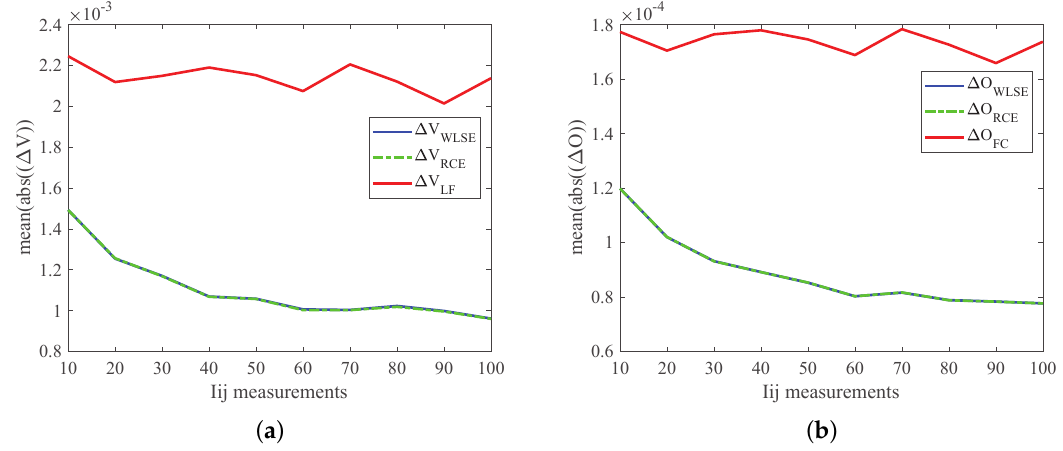
Figure 4. 117-bus system: ( a ) accuracy of voltage magnitudes; ( b ) accuracy of voltage phase angles (rad).